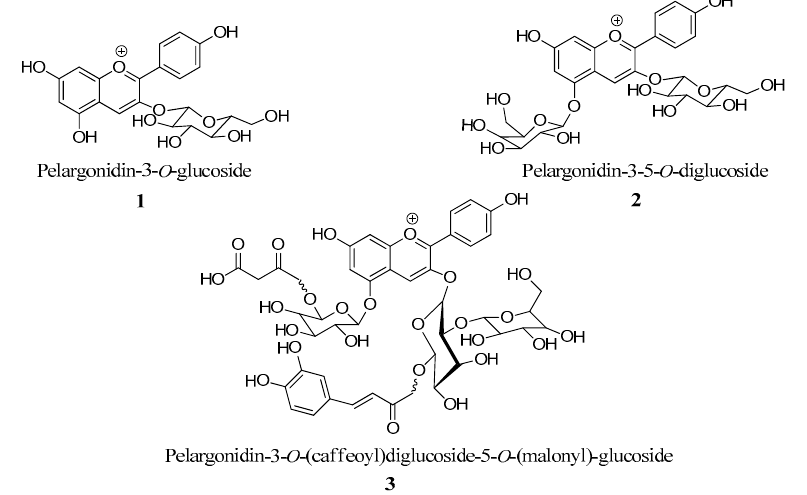
Figure 2. Structures of pelargonidin derivatives 1 – 3 putatively present in red radish extract.